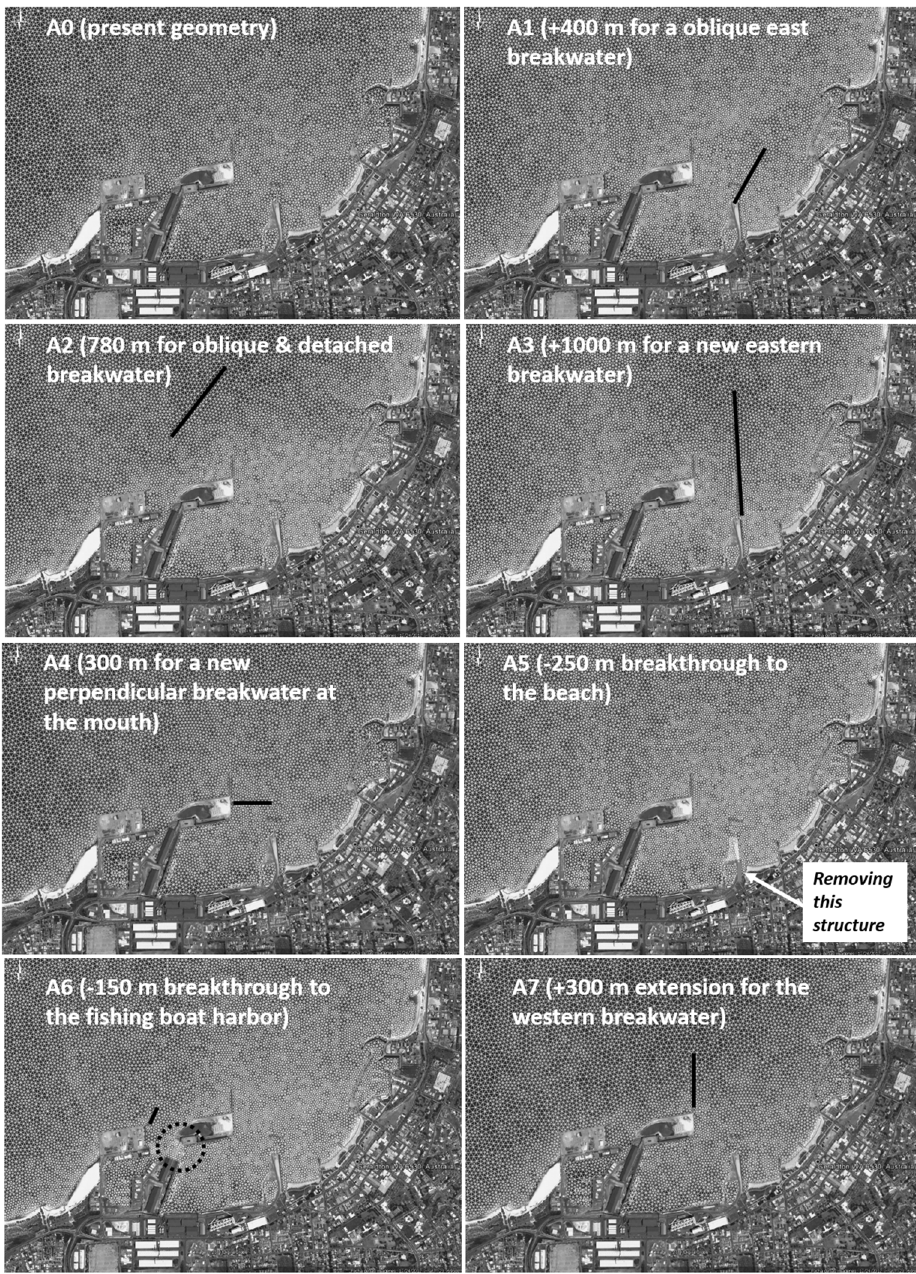
Figure 8. Pre ‐ design geometries proposed as the first analysis of possible solutions. Figure 8. Pre-design geometries proposed as the first analysis of possible